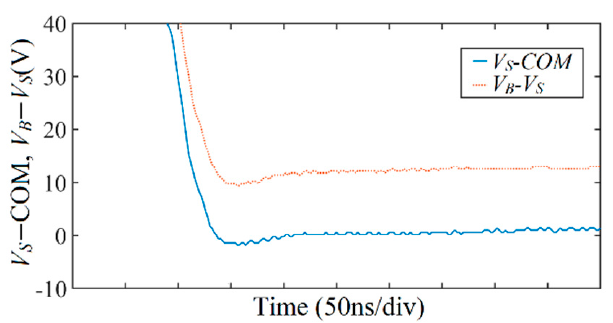
Figure 12. VS-undershoot phenomena under a 150% overload condition.